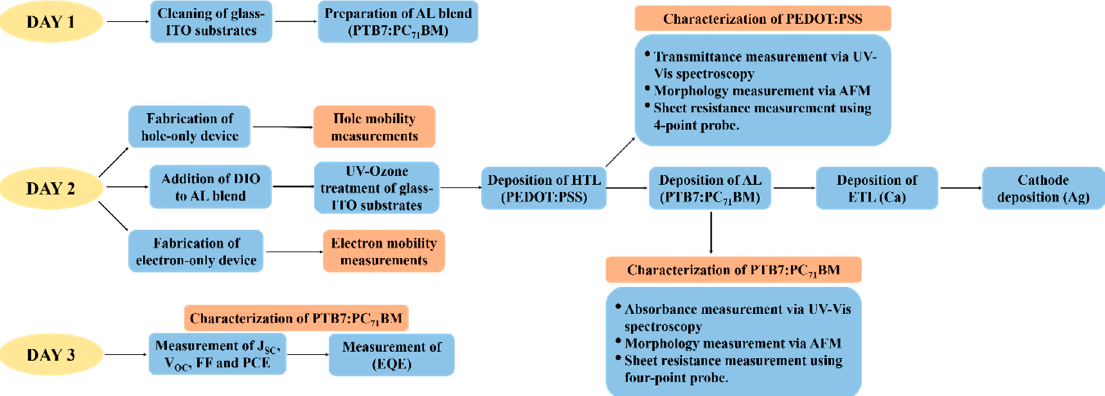
Figure 2. The flow chart of the three days experiment step-by-step. ITO: indium-tin oxide; AL: active layer; ETL: electron transport layer; HTL: hole transport layer; EQE: external quantum efficiency; J SC : short circuit current density; V OC : open circuit voltage; FF: fill factor; PCE: power conversion efficiency; DIO: 1,8-Diiodooctane; AFM: atomic force microscopy.